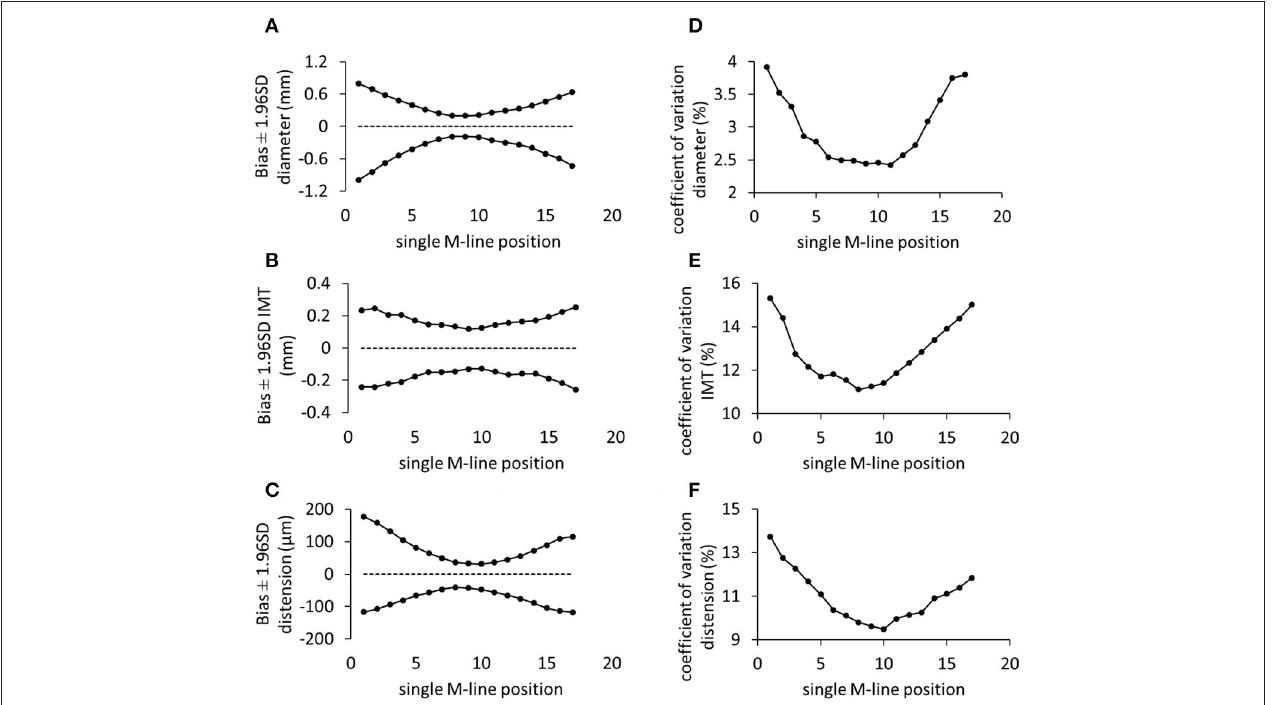
FIGURE 3 | The performance of individual M-lines in terms of the agreement from the Bland-Altman analysis (A–C) and reproducibility coefficient of variation (D–F) for diameter, intima-media thickness (IMT), and distension, respectively. SD, standard